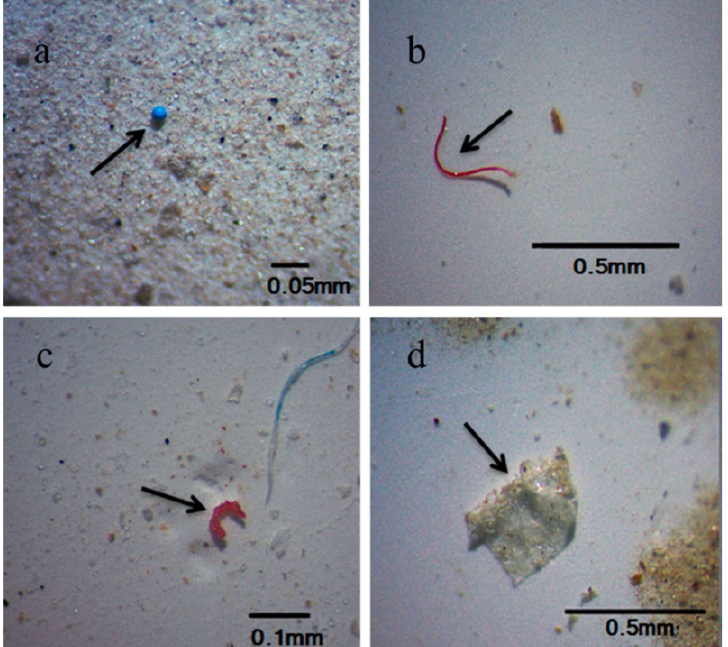
Figure 1. Types of MPs in the surface water and sediments from coastal Guangdong ( a – d ): ( a ) pellets, ( b ) fibers, ( c ) fragments, ( d ) films